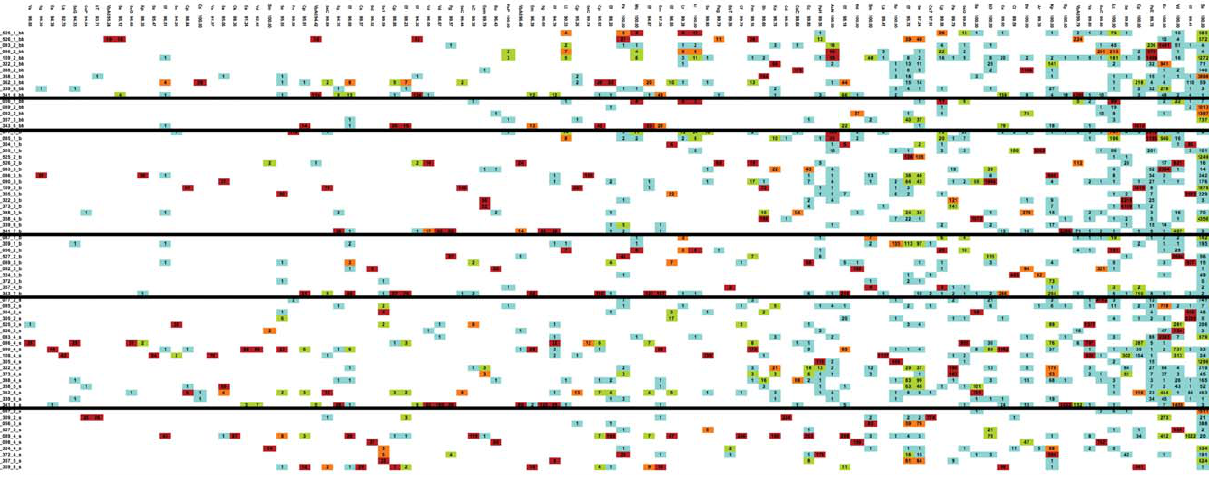
Figure 1. Heatmap showing the distribution of the most prevalent OTUs at 98% similarity level. List of full names for closest matches shown by abbreviation in Figure 1 are listed below: ArActinomyces_radingae AsNAchromobacter_sp._N2 bCbacterium_C20 BdBacteroides_dorei BdBacteroides_dorei bDbacterium_DR304 BsCBacteroides_sp._CB53 BsTBosea_sp._TPR12 bTbacterium_Te14R BuBacteroides_uniformis BvBacter- oides_vulgatus CdClostridium_disporicum CfCitrobacter_freundii CkCitrobacter_koseri ClClostridium_lavalense CpClostridium_perfringens Cs1Clos- tridium_sporogenes Cs2Clostridium_sordellii Cs3Clostridium_sp._75064 CsCClostridium_sp._CS4 CsPClostridium_sp._PN6–15 EaEnterococcus_avium EcEnterobacter_cancerogenus EcEscherichia_coli Ef1Enterococcus_faecalis Ef2Enterococcus_faecium EmEnterococcus_malodoratus EsmEnterobac- ter_sp._mcp11b FmFinegoldia_magna FnFusobacterium_nucleatum KoKlebsiella_oxytoca KpKlebsiella_pneumoniae LaLactobacillus_animalis LcLeuconostoc_citreum LlLactococcus_lactis LpLactococcus_plantarum LrLactococcus_raffinolactis Pa1Propionibacterium_acnes Pa2Pantoea_agglo- merans PgPropionibacterium_granulosum PsEPhyllobacterium_sp._EBBLQ01 PsgPeptoniphilus_sp._gpac121 PsHPropionibacterium_sp._H456 RsPRhodococcus_sp._PN8 Sa1Staphylococcus_aureus Sa2Streptococcus_agalactiae SeStaphylococcus_epidermidis Sg1Serratia_grimesii Sg2Strepto- coccus_gallolyticus ShStaphylococcus_hominis SmSerratia_marcescens SmStenotrophomonas_maltophilia SpStaphylococcus_pasteuri SsStrepto- coccus_salivarius Ss1Streptococcus_sp._10aVMg3 SsCStaphylococcus_sp._C-12 SsCSerratia_sp._CJB2 SsGStreptococcus_sp._G3 SvStreptococcus_- vestibularis VaVeillonella_atypica VbAVeillonellaceae_bacterium_ADV_07/08/06-B-1388 VdVeillonella_dispar WcWeissella_confusa.